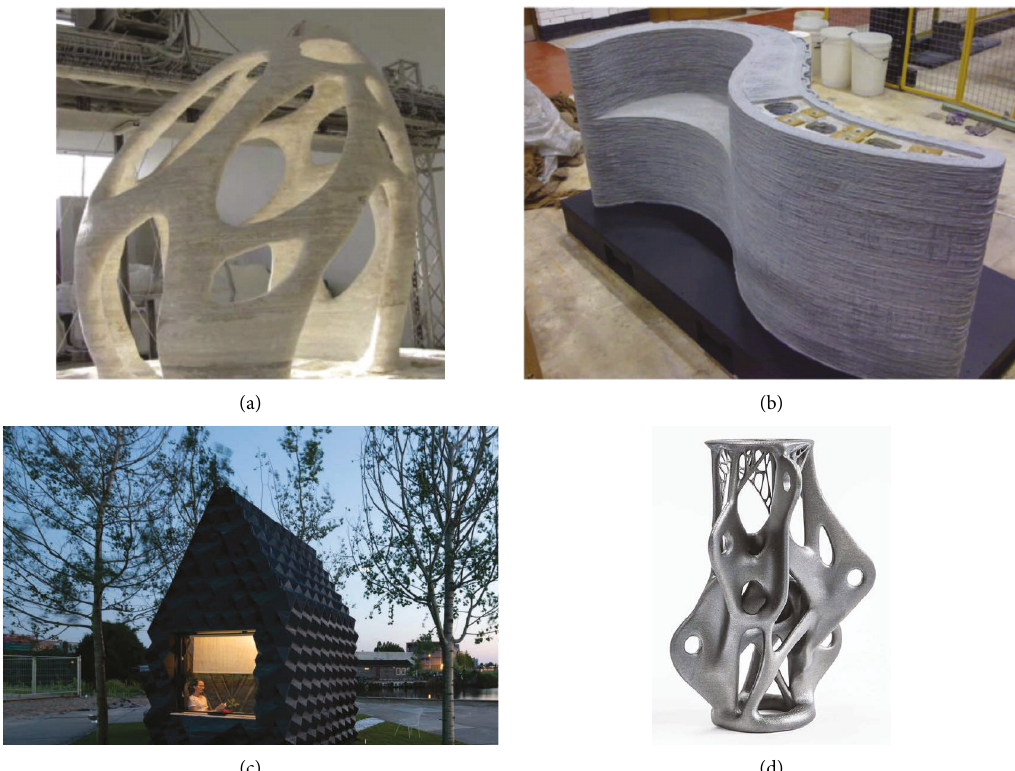
Figure 2: Printed work display of building 3D printing technology ((a) concrete printed back chair, (b) sculpture superimposed by gravel, (c) DUS Company printed riverside office by plastic fiber, and (d) ARUP Company printed steel structure) [5,